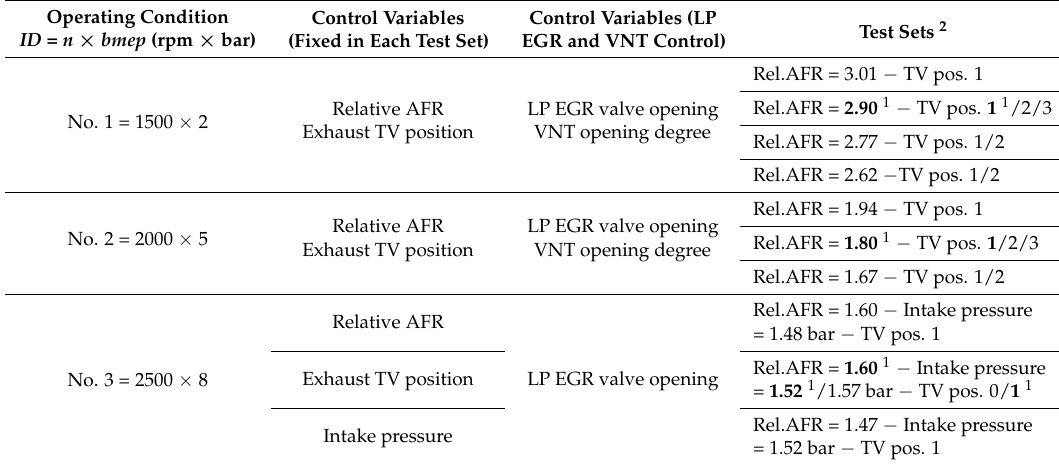
Table 3. Schedule of experimental activities. ID : identification number; bmep : brake mean effective pressure; AFR: air-fuel ratio; TV: throttle valve; and pos.: